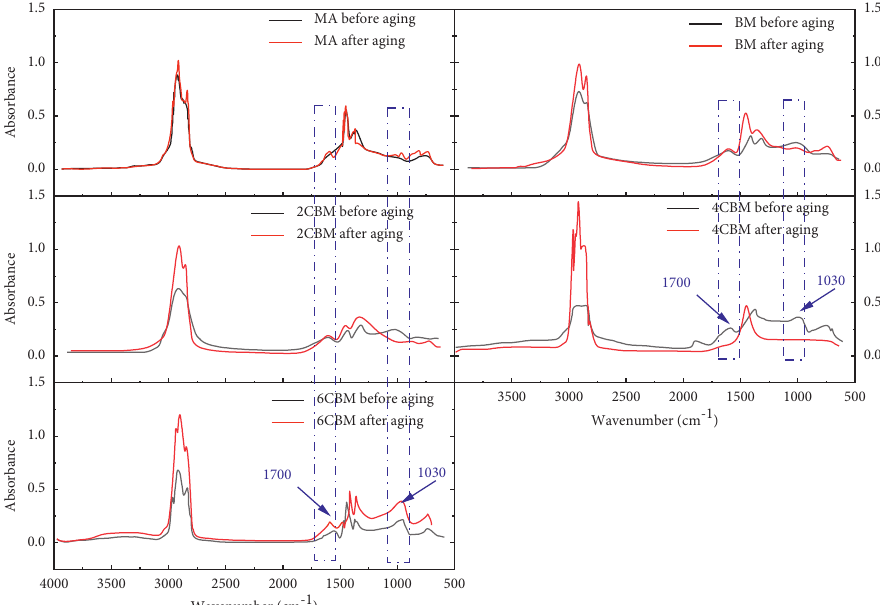
Figure 9: Infrared spectra of different